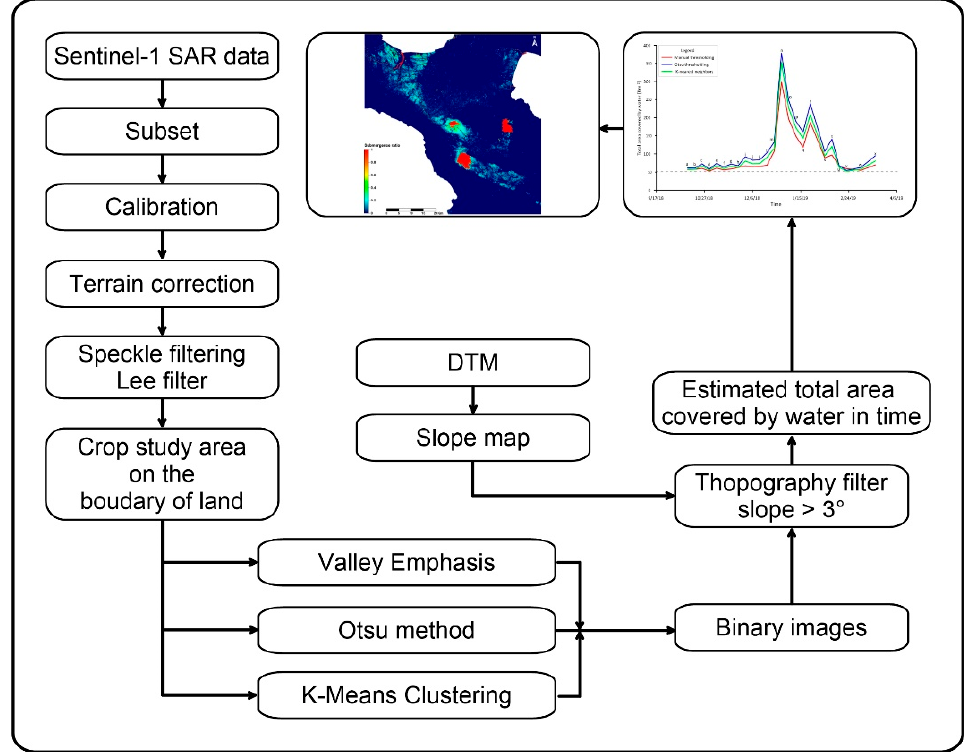
Figure 4. Processing workflow of SAR imagery for estimating the total surface covered by water across the study area in the reference period.